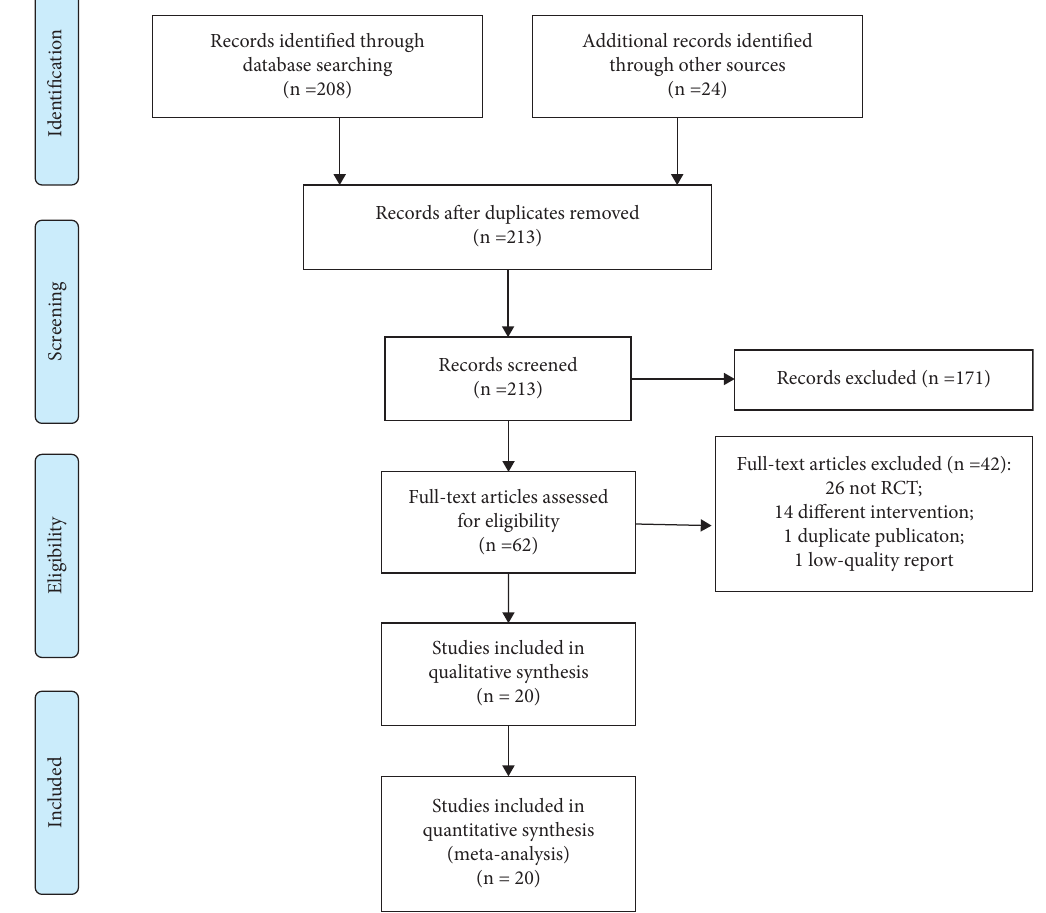
Figure 1: PRISMA fow diagram of study